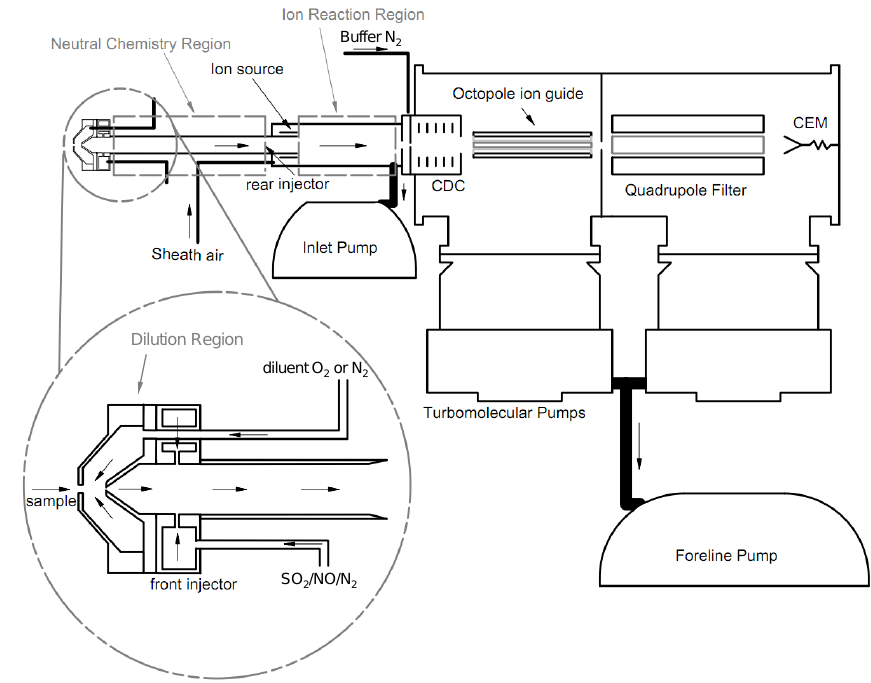
Fig. 1. Schematic of PeRCIMS instrument, with inset of modified inlet and dilution